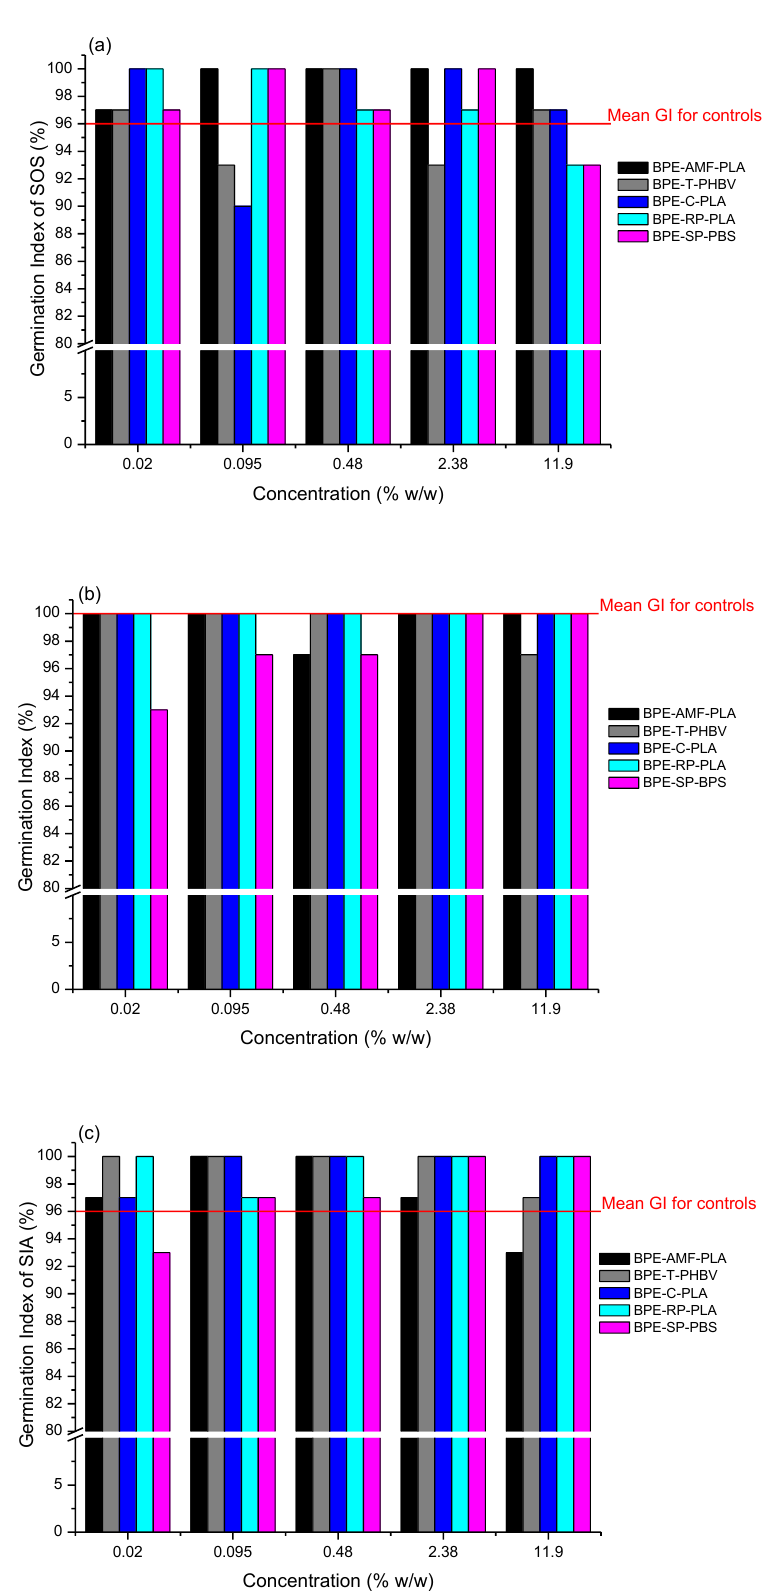
Figure 1. Effect of bio-based plastics on seed germination of higher plants: ( a ) Sorghum saccharatum (SOS); ( b ) Lepidium sativum (LES); ( c ) Sinapsis alba (SIA).